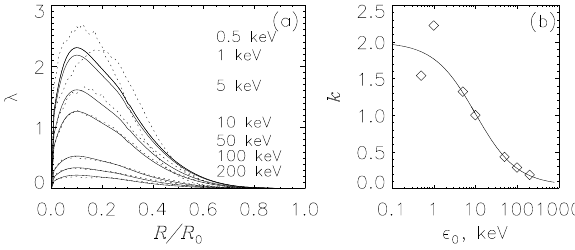
Figure 4: 2007.12.18: Y. Hiraki and C. Tao Fig. 4. (a) The profile function λ of the ionization rate as a function of the reduced column mass density R/R 0 . The dotted curves show 18 the calculated values with Eq. (2) directly by using q ion , R 0 , and ε ion in Figs. 1 and 3, whereas the solid ones are the scaled values of a fitted ε 0 = 10keV one by using the ratio k (see text for the de- tails of k ). (b) The k values (diamonds) and fitted curve of the ε 0